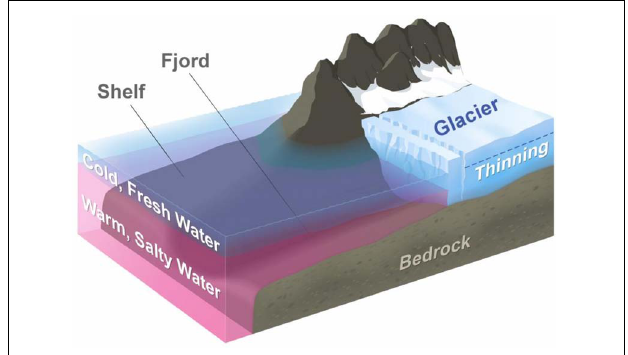
FIGURE 7 | Typical configuration of a marine terminating glacier in Greenland. The layer of cold, fresh Arctic water poses little threat to these glaciers, which usually terminate in a near-vertical face. However, glaciers sitting in water that is greater than about 250 m can encounter warm, salty water from the Atlantic. This accelerates melt and can result in glacier retreat and sea level rise. Currently, there is no system for monitoring the temperature or thickness of this warm salty layer, which is found nearly everywhere on the continental shelf and in fjords surrounding the entire